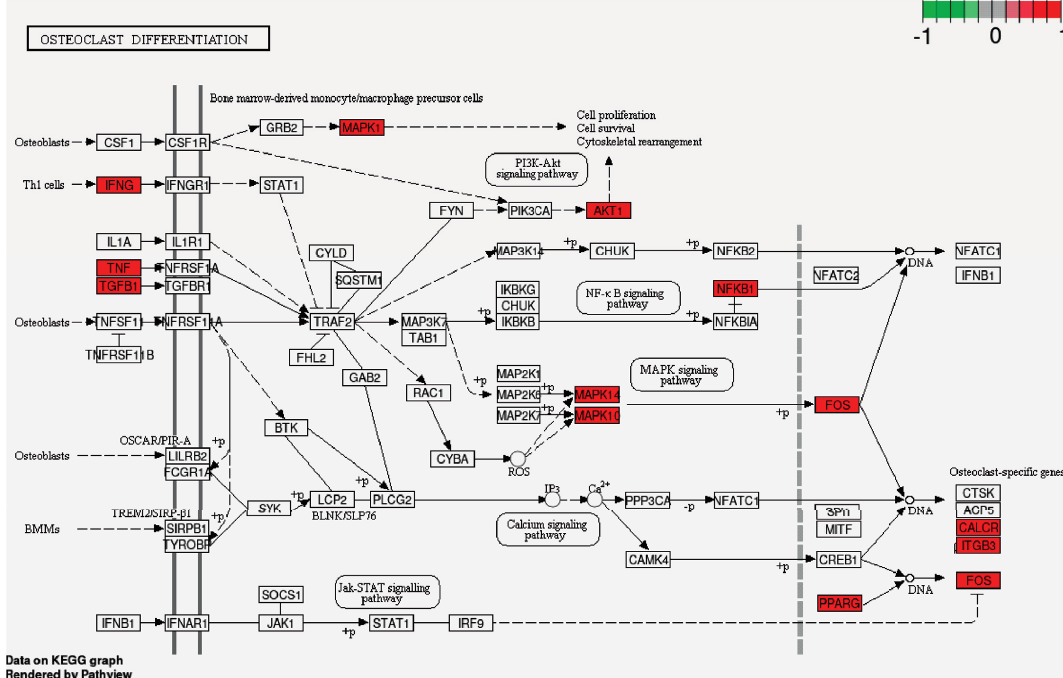
Figure 8: The diagram of the osteogenic differentiation